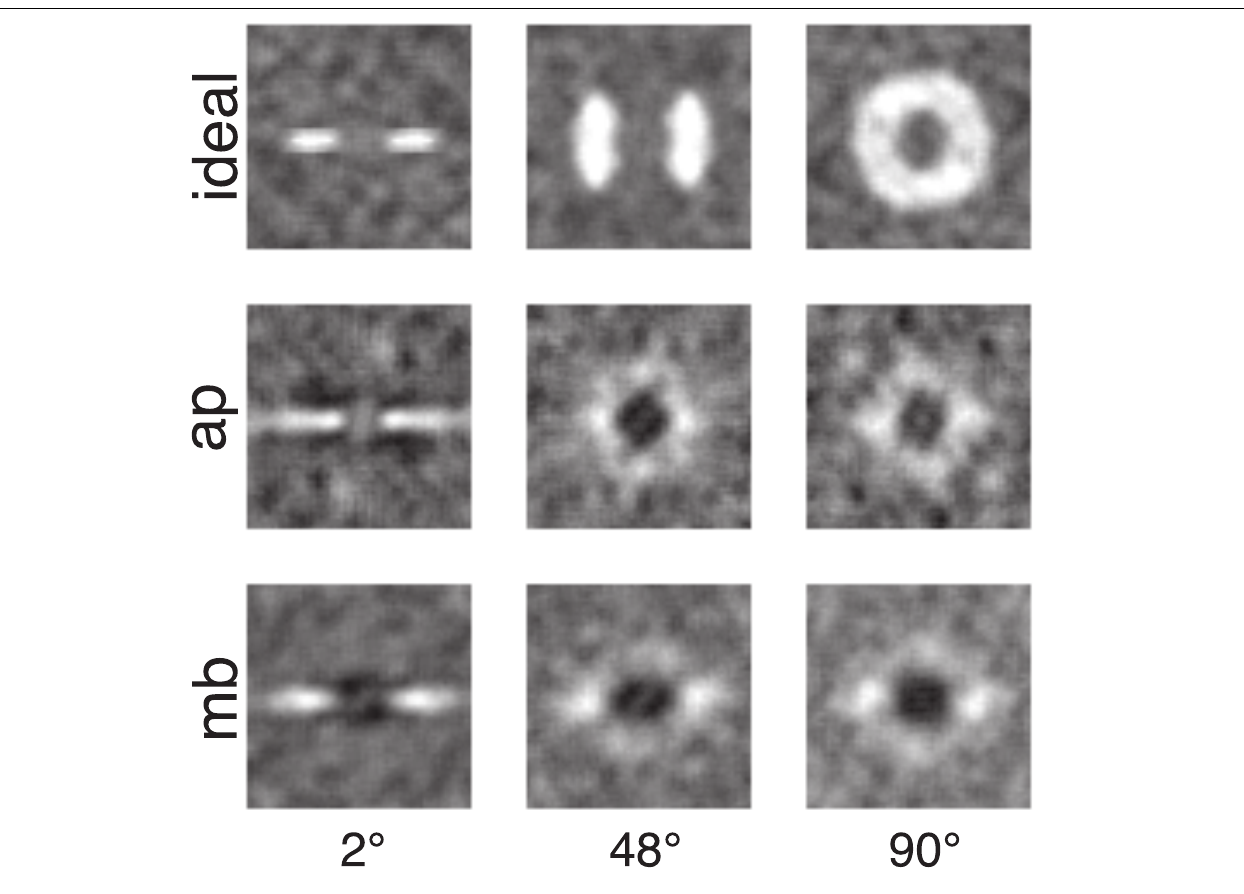
FIGURE 5 | Smoothed classification images for the same conditions and observers presented in Figure 4. White regions represented where power in the stimulus is correlated with a correct detection response, whereas the dark or black regions indicate regions where